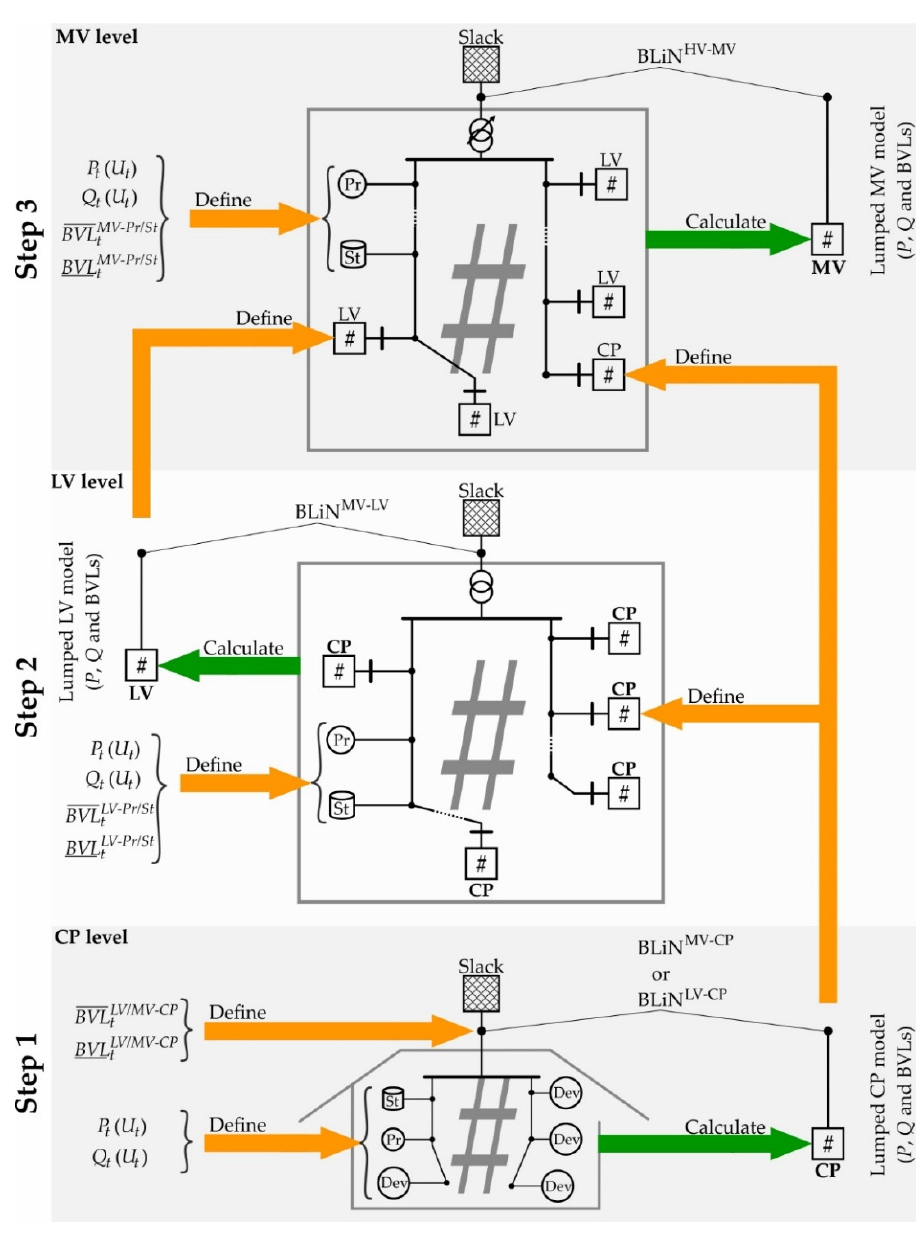
Figure 17. Overview of the systematic modeling of the Link-Grids in the vertical power system axis.